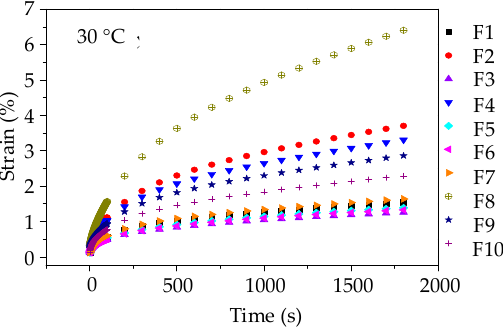
Figure 5. Creep strain-time curves of asphalt mortars at 30 ° C.